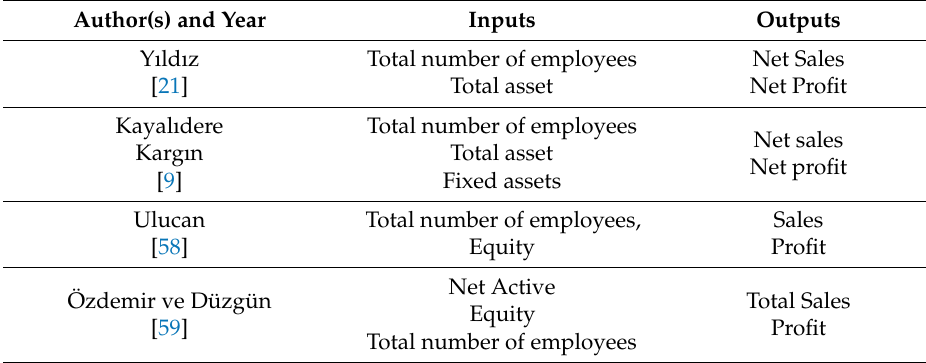
Figure 2. Application Steps (DEA: Data Envelopment Analysis; BCC: Banker, Charnes ve Cooper; CCR: Charnes, Cooper ve Rhodes; AHP: Analytical Hierarchy Processes; KOSGEB: Small and Medium Enterprises Development and Support Administration; TOPSIS: Technique for Order Preference by Similarity to Ideal Solution. Table 3. Input and Output variables in